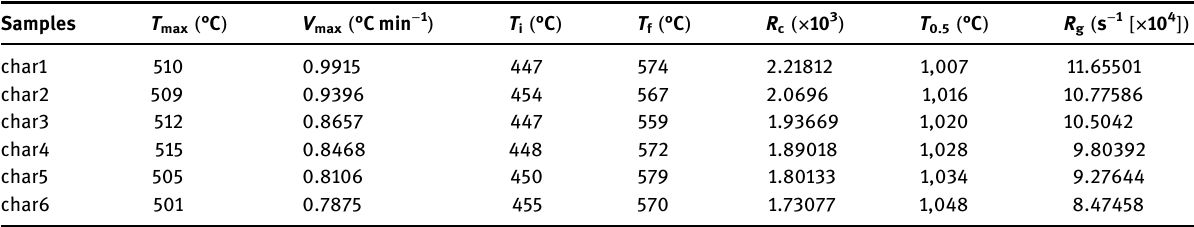
Table 2: Characteristic parameters of semi - coke during combustion and gasi fi cation processes